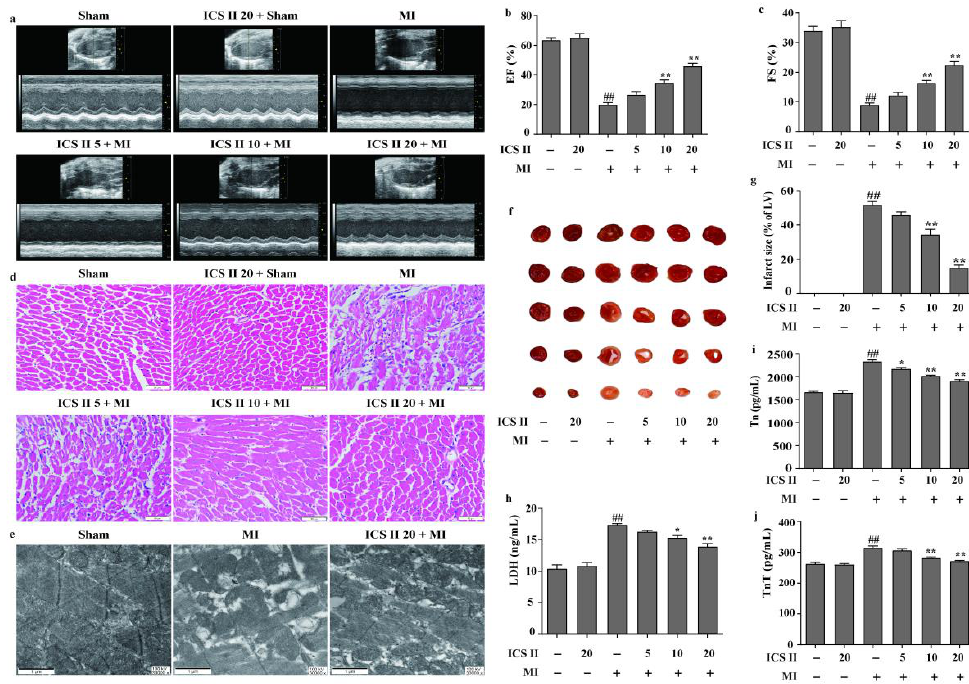
Figure 1. ICS II alleviated MI-induced myocardial damage in mice: ( a ) cardiac function was measured using Doppler echocardiography; ( b ) EF (%) ( n = 6); ( c ) FS (%) ( n = 6); ( d ) HE staining was performed to observe the pathological changes in the left ventricle. Magnification × 400; scale bar, 50 μm ; ( e ) mitochondrial morphology was observed via TEM. Magnification × 30,000; scale bar, 1 μm ; ( f ) myocardial infarct size was performed via TTC staining; ( g ) quantitative data of myocardial infarct size (%) ( n = 5); ( h ) LDH activity ( n = 6); ( i ) Tn level ( n = 6); ( j ) TnT level ( n = 6). The data are presented as the mean ± SEM. ## p < 0.01 vs. sham; * p < 0.05, ** p < 0.01 vs.